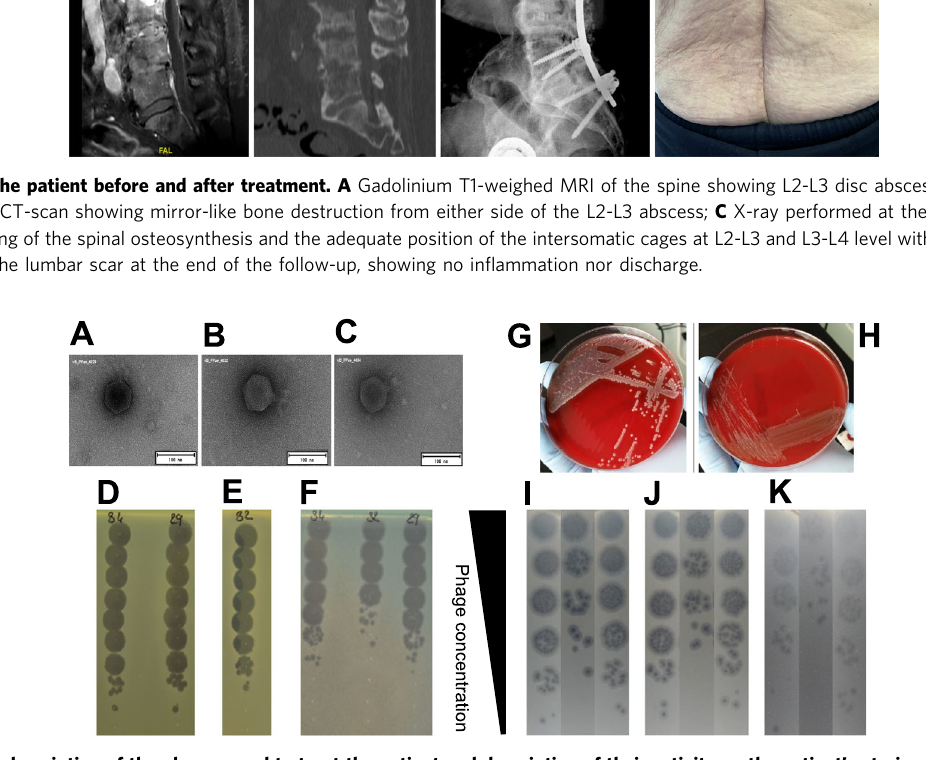
cultured from a bone sample taken from the second-stage surgery procedure, that was close to the initial strain; H One of the two P. aeruginosa corresponds to a stable Small Colony Variant (SCV) morphotype; I Visualization of Plaque Forming Units (PFU) of the phage vB_PaeP_4029 on the patient ’ s strains isolated before phage therapy or during the second-stage surgery procedure; J Visualization of Plaque Forming Units (PFU) of the phage vB_PaeP_4032 on the patient ’ s strains isolated before phage therapy or during the second-stage surgery procedure; K Visualization of Plaque Forming Units (PFU) of the phage vB_PaeP_4034 on the patient ’ s strains isolated before phage therapy or during the second-stage surgery